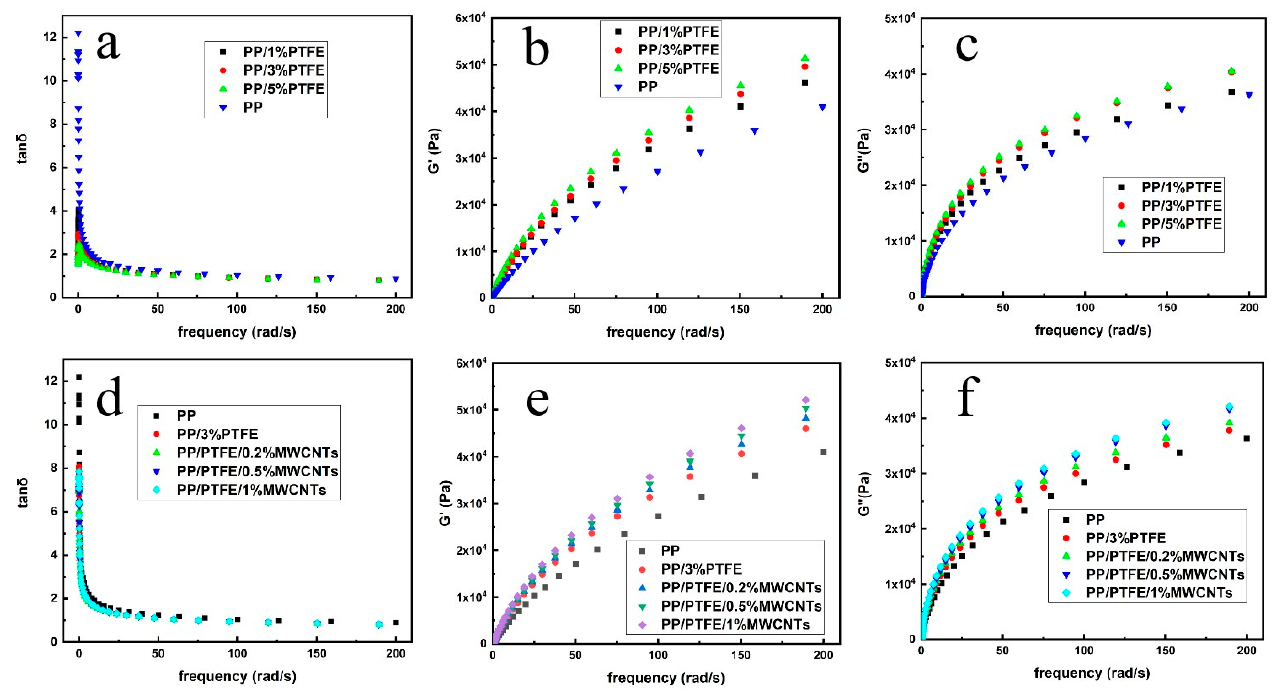
Figure 7. Rheological properties of PP, PP/PTFE, PP/PTFE/MWCNTs ( a , d ) tan δ ; ( b , e ) G’; ( c , f ) G”.